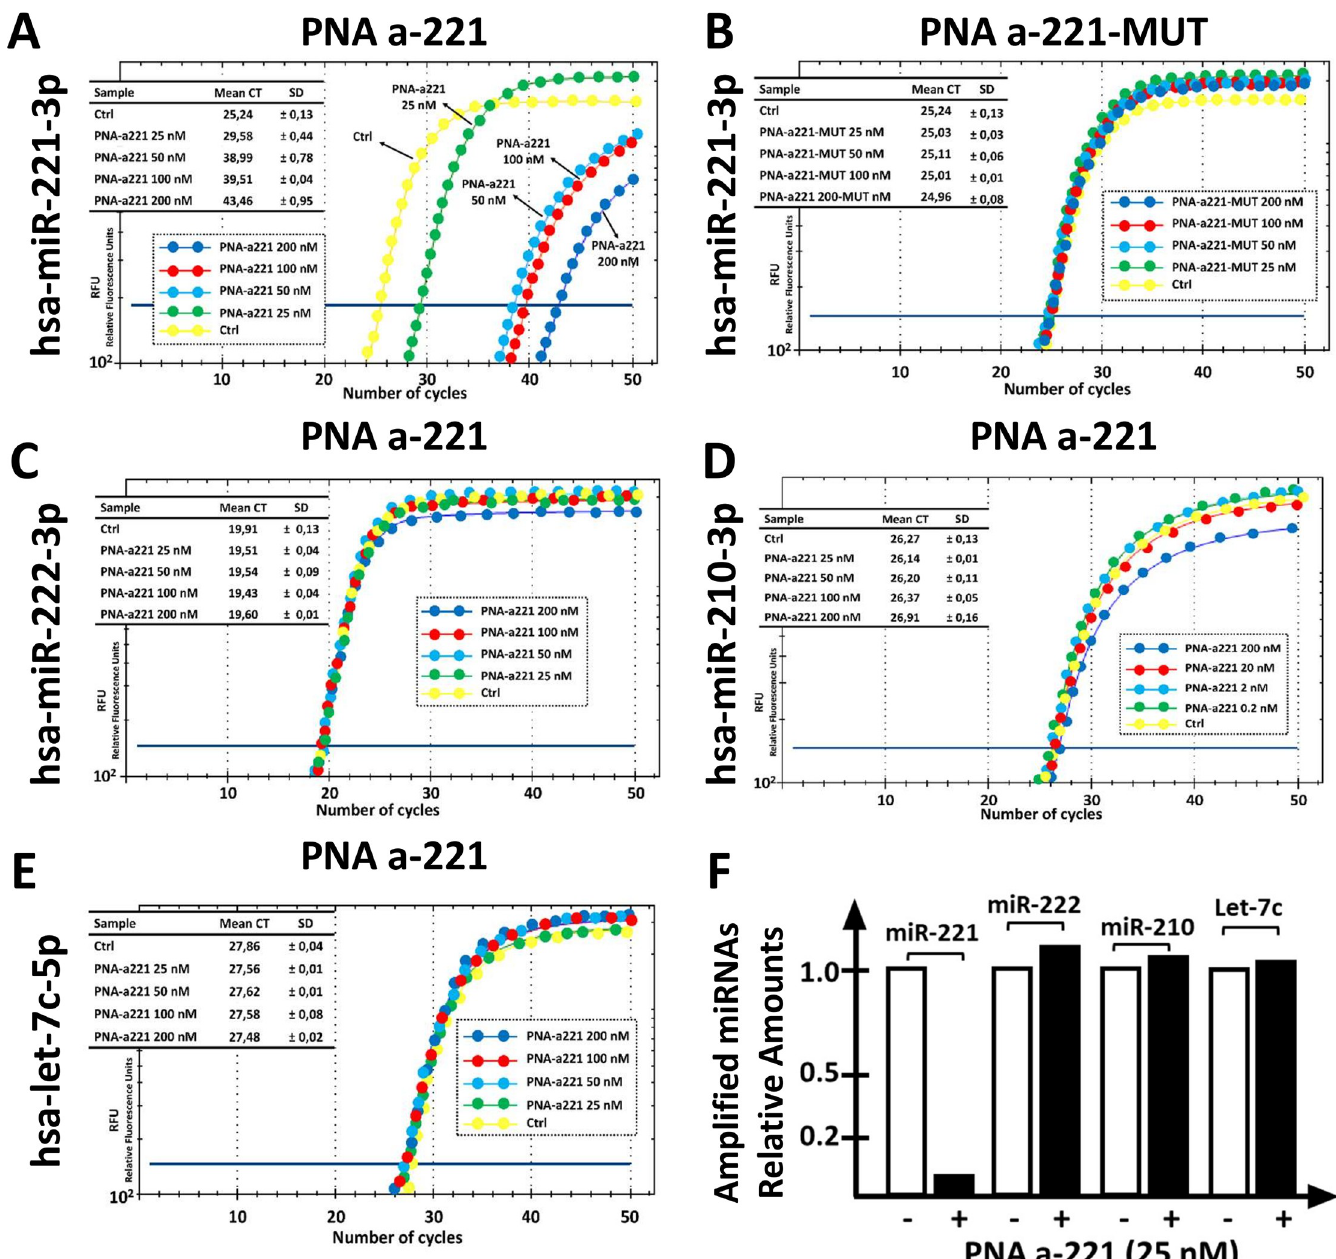
Fig 2. Effects of the PNA-a221 on the RT-PCR amplification of miRNA sequences. A,B. Effects of increasing amounts of PNA-a221 (A) and mutated PNA- a221-MUT (B) on the amplification of miR-221-3p sequences. C-E. Effects of increasing amounts of PNA-a221 on the amplification of miR-222-3p (C), miR-210-3p (D) and let-7c-5p (E) sequences. F. Summary of the effects of 25 nM PNA-a221 on amplification of the indicated miRNA sequences. The comparison of the effects of 50, 100 and 200 nM PNA-a221 are presented in Figure E in S1 File.